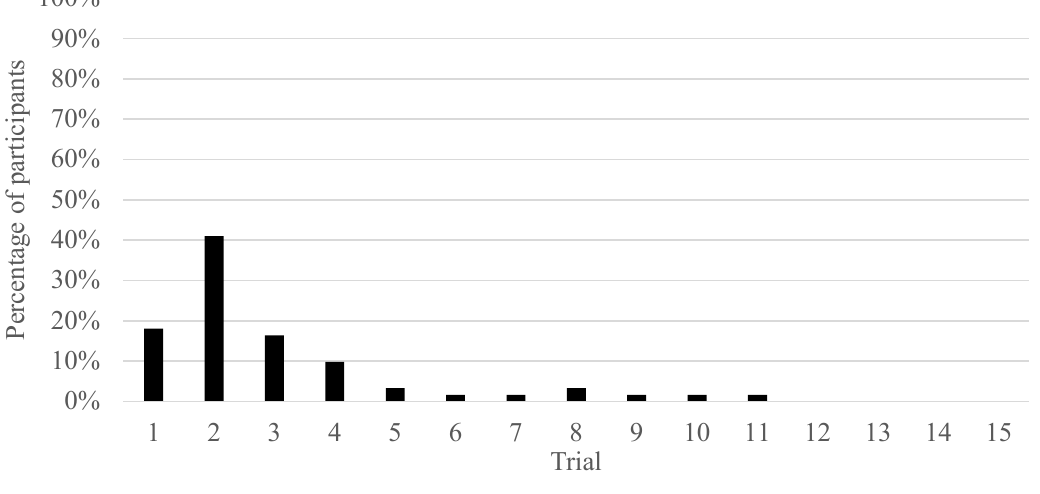
Figure 7. Participants first pass by trial.